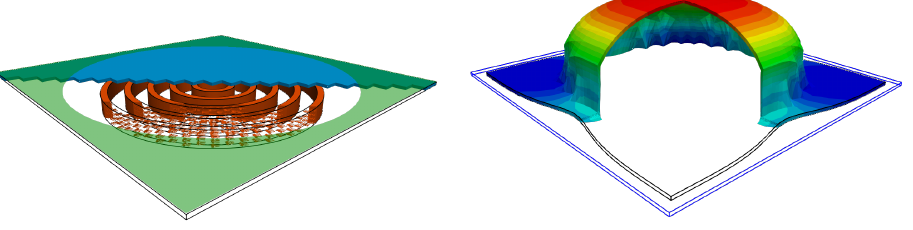
Figure 14. Magnetic metal forming. Setup ( left ) and snapshot ( right